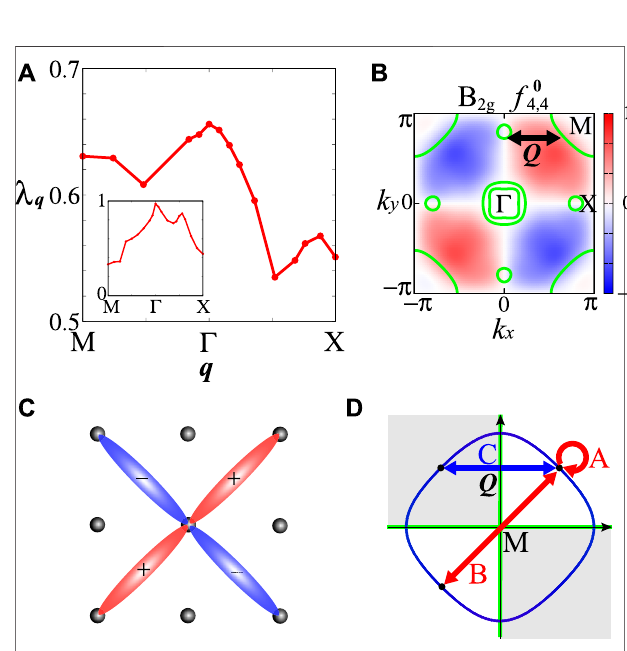
FIGURE 12 | (A) q dependence of λ q with self-energy in CsFe 2 As 2 , and that without self-energy in the inset. (B) k dependence of the B 2 g form factor f 0 4 , 4 ( k ) ∝ sin ( k x ) sin ( k y ) , where the green lines and black arrow denote FSs and nesting vector Q ~ (0.5 π , 0), respectively. (C) B 2 g next-nearest- neighbor bond order corresponding to the f 0 4 , 4 ( k ) . (D) B 2 g form factor ∝ sin( k x )sin( k y ) driven by the attractive interactions (red arrows) A and B, and the repulsive interaction (blue arrow) C in the DW equation, where green lines denote nodes in the B 2 g form